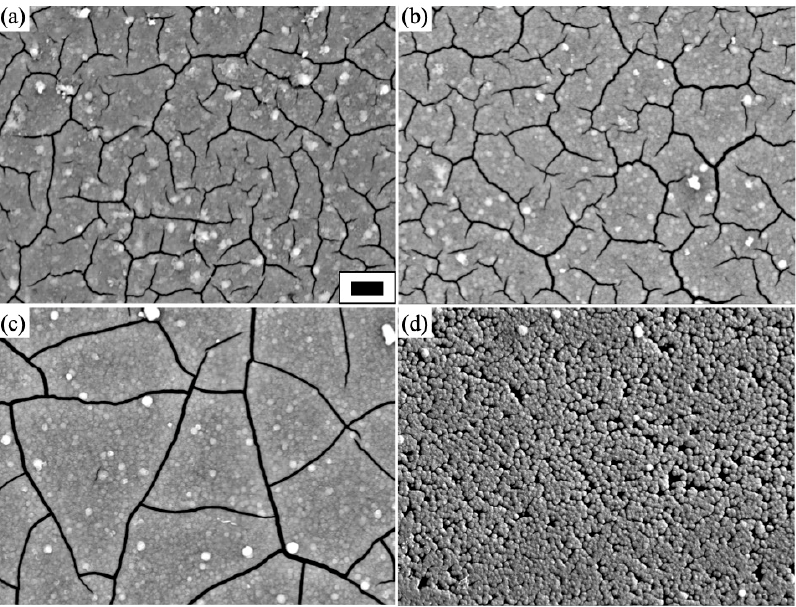
Figure 5. SEM images of Cu-doped TiO 2 coatings with different dopant concentrations: ( a ) 0, ( b ) 0.1, ( c ) 1, and ( d ) 10 mM. Scale bar indicates 2 μ m.